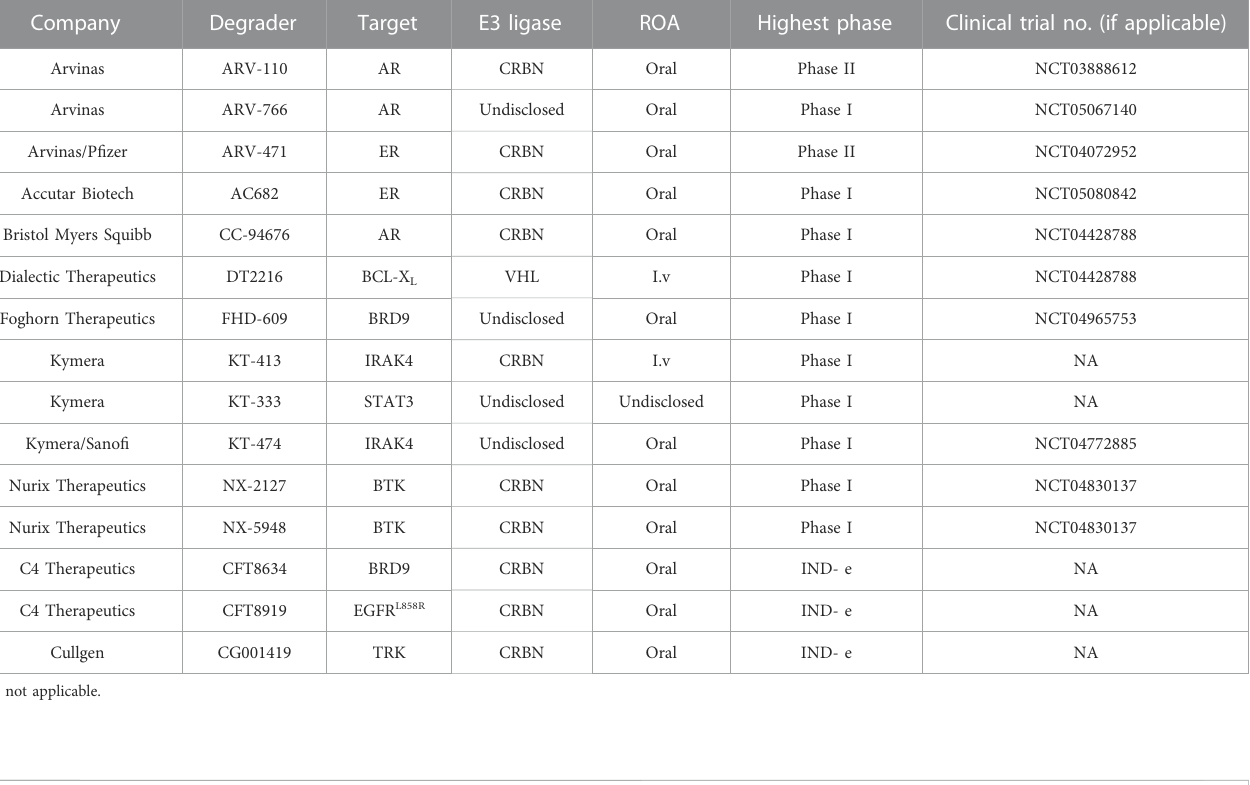
TABLE 1 PROTAC degraders in clinical development.